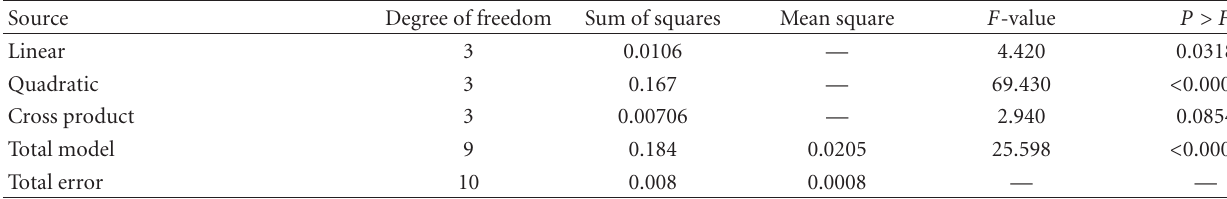
Table 5: ANOVA for the second-order polynomial model.